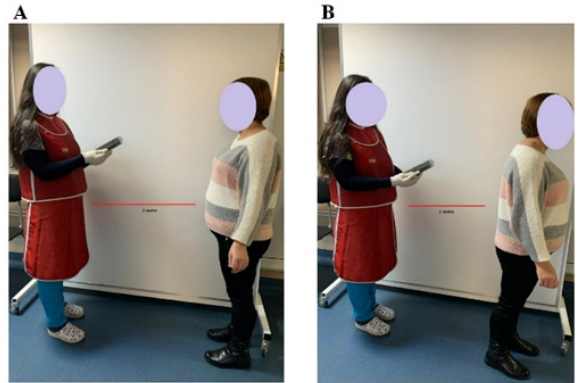
Figure 1. Radioactivity measurements performed at a distance of 1 m from the patient’s abdomen ( A ) frontal position; ( B ) posterior